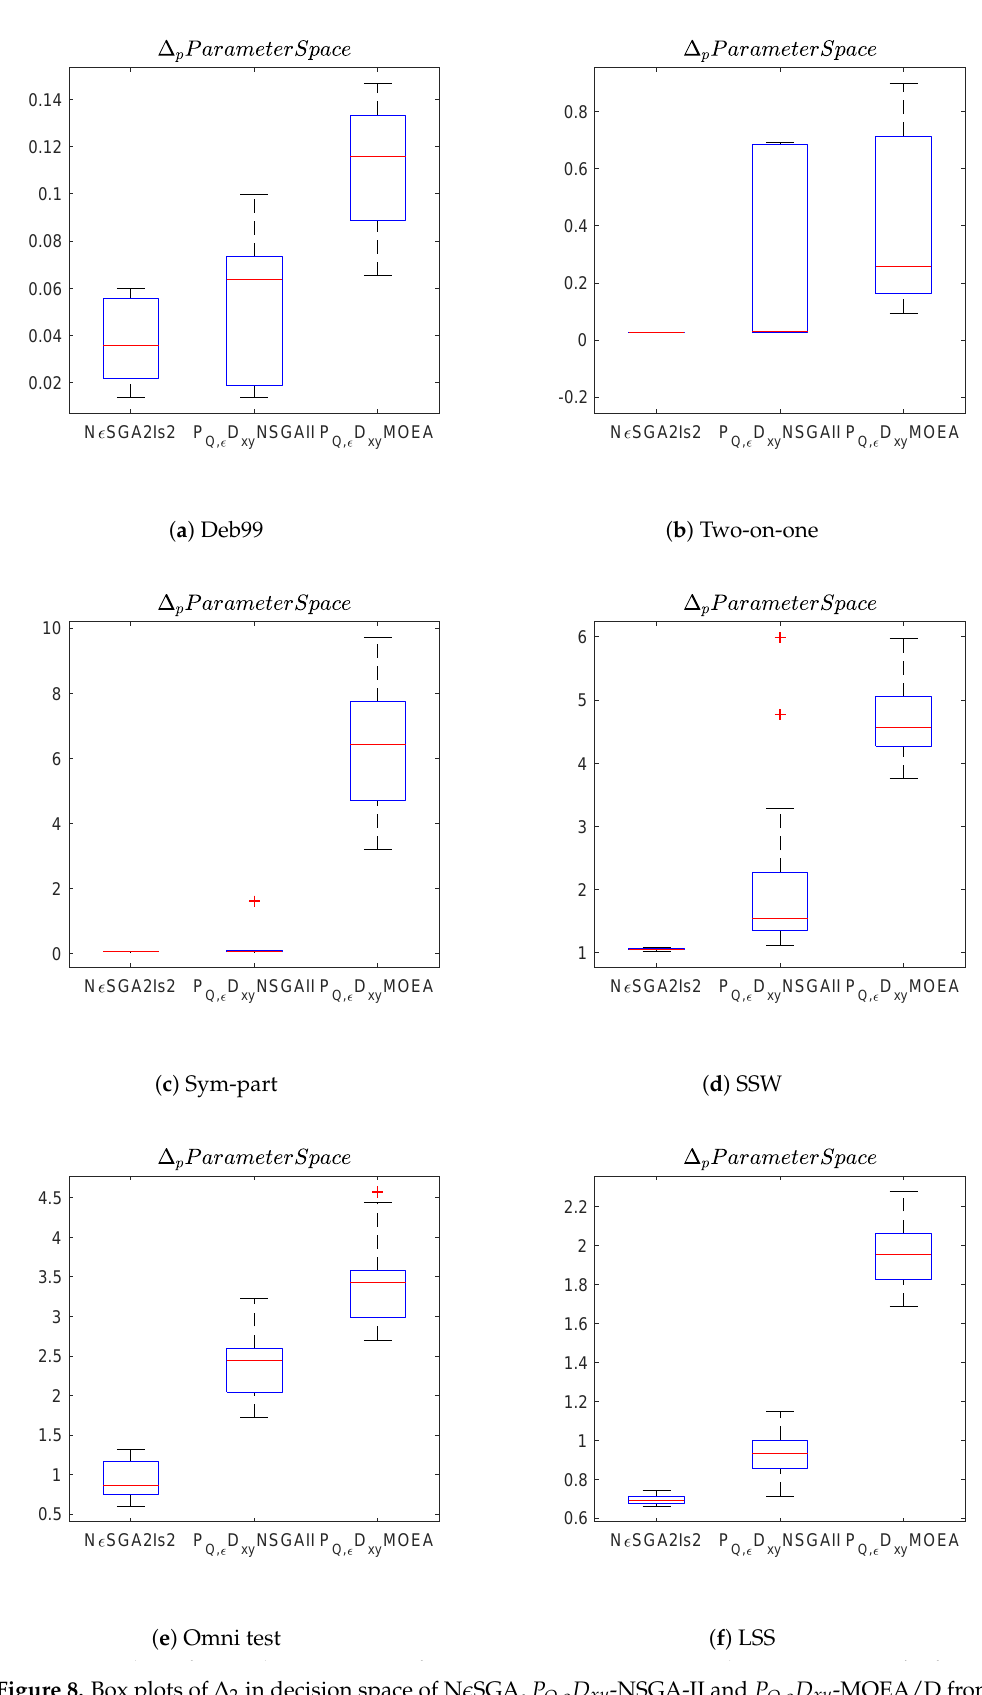
Figure 8. Box plots of ∆ 2 in decision space of N e SGA, P Q , e D xy -NSGA-II and P Q , e D xy -MOEA/D from left to right.